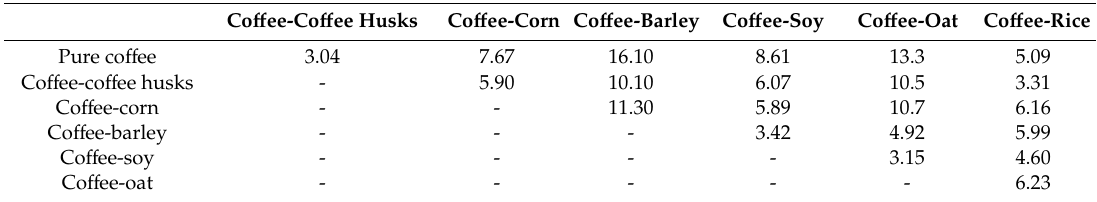
Table 1. Interclass distance of the soft independent modeling of class analogy (SIMCA) model.